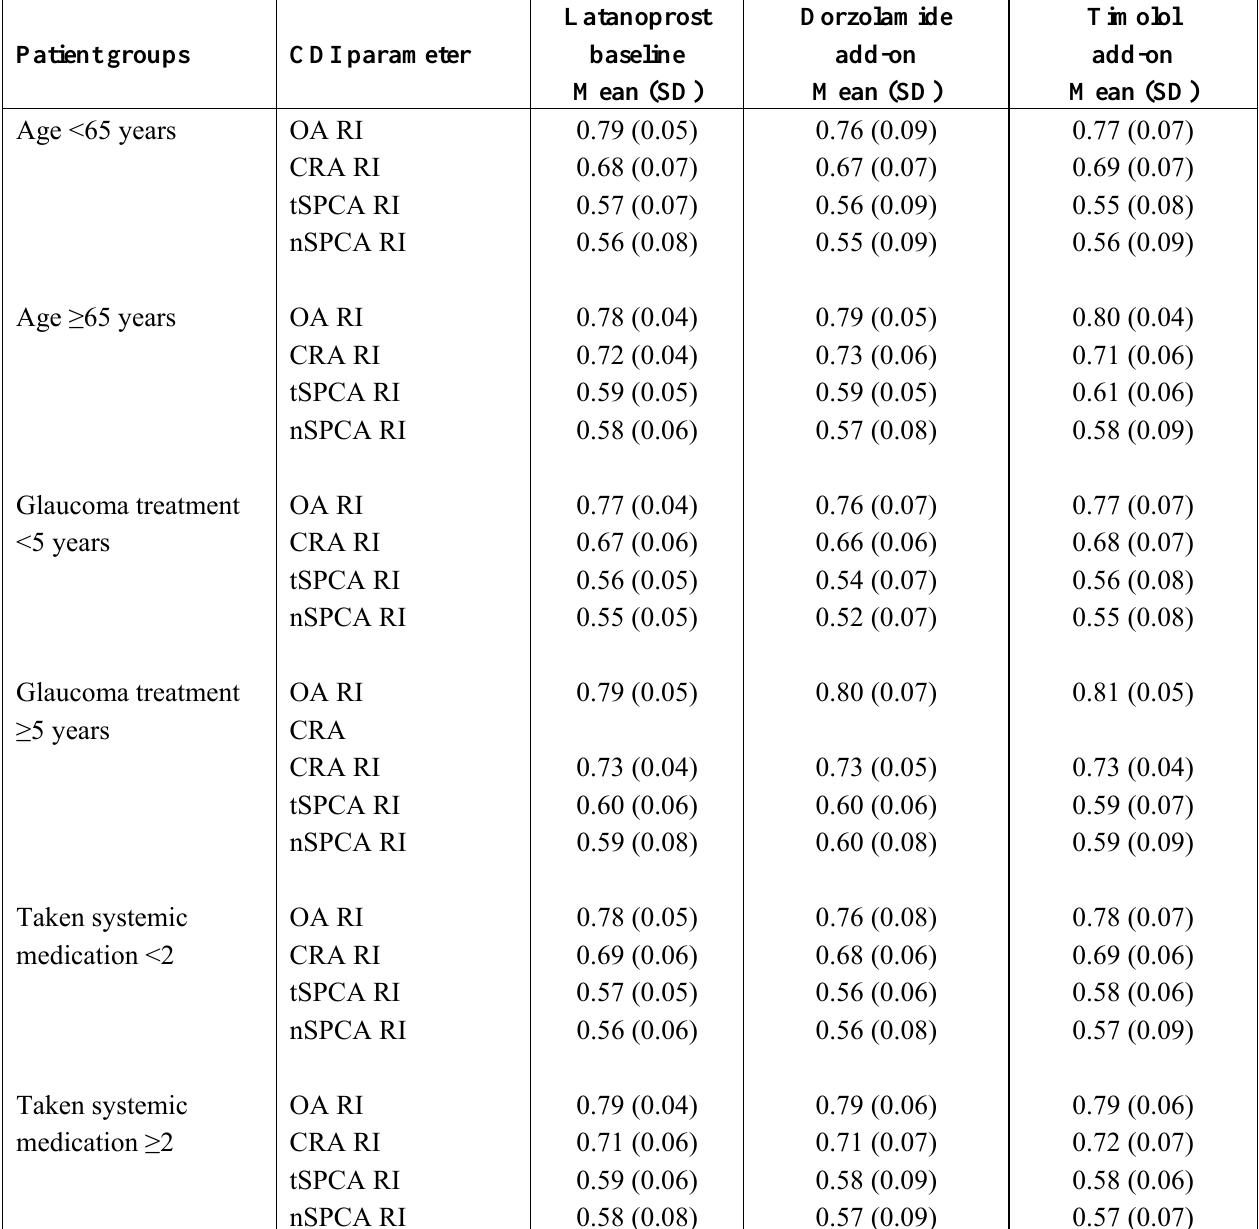
Table 4. Changes of diurnal CDI parameters in different